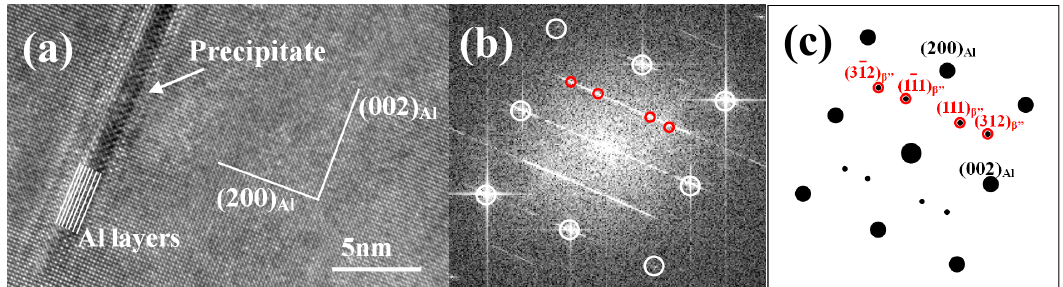
Figure 14. Acicular precipitate in the peak-aged Alloy 2 (165 °C/480 min) observed via the <010> Al direction: ( a ) HRTEM image; ( b ) corresponding FFT; ( c ) simulated pattern.